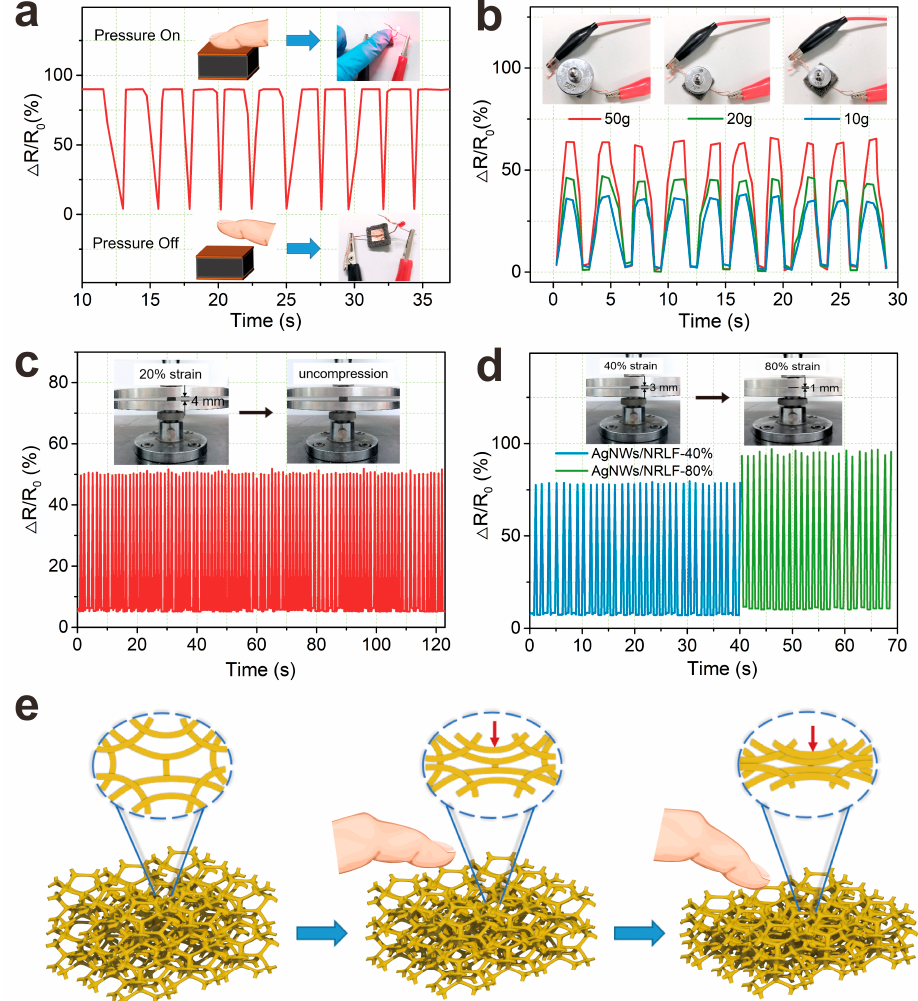
Figure 7. ( a , b ) relative resistance variation of the AgNWs/NRLF sensors under small compression strains (finger pressure and cyclic 50 g, 0 g, 10 g weight); ( c , d ) cyclic piezoresistive reaction of AgNWs/NRLF sensors under large compression strains (20%, 40% and 80%); (e) schematic of the piezoresistive effect under compressive deformation.